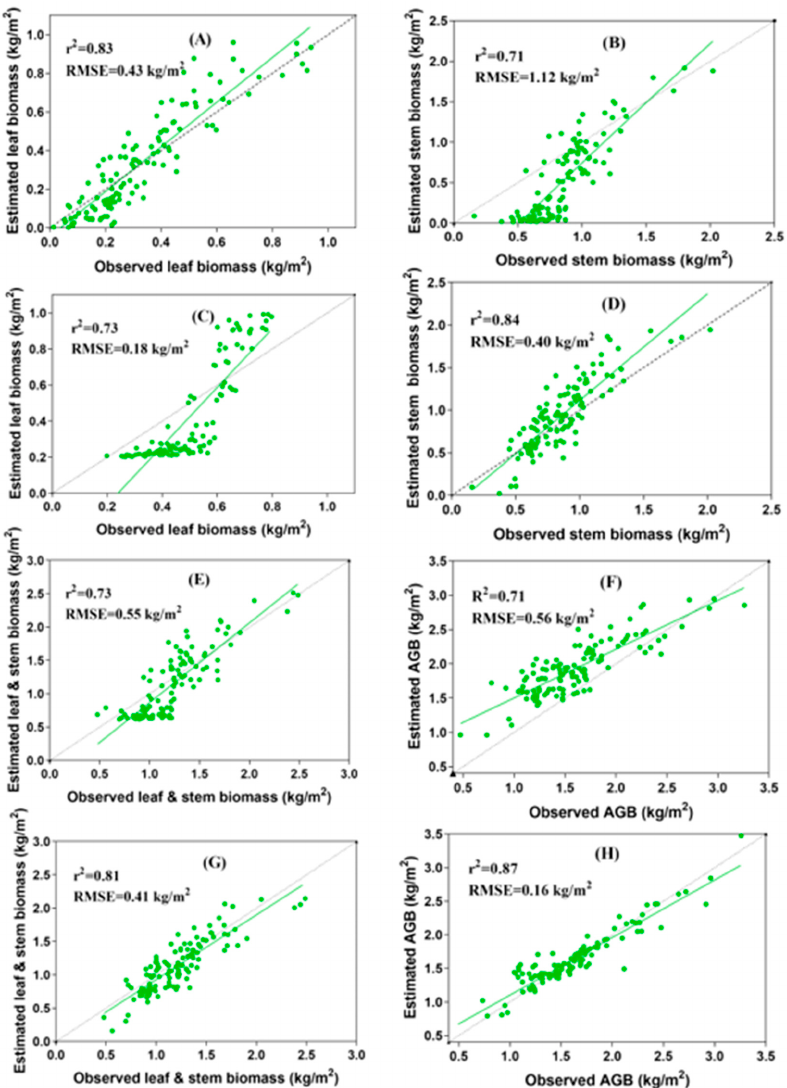
Figure 6. Comparisons between measured and estimated biomass components using multi-target Gaussian process regressor stacking (MGPRS) for ( A ) leaf biomass using SOMVI, ( B ) stem biomass using SOMVI, ( C ) leaf biomass using SODVI, ( D ) stem biomass using SODVI, ( E ) stem and leaf biomass using SOMVI, ( F ) AGB using SOMVI, ( G ) leaf and stem using SODVI, and ( H ) AGB using SODVI. The green line represents a linear regression between the observed and estimated values and the dashed line represents the 1:1 line.